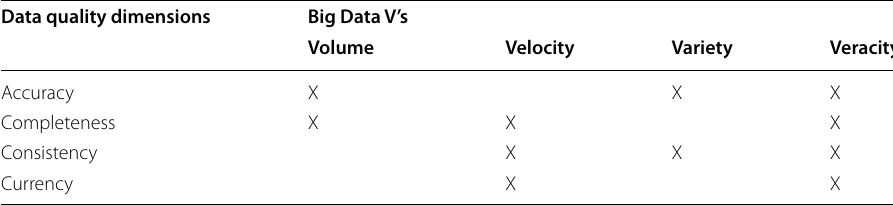
Table 3 Example of intrinsic DQD’s vs. big data